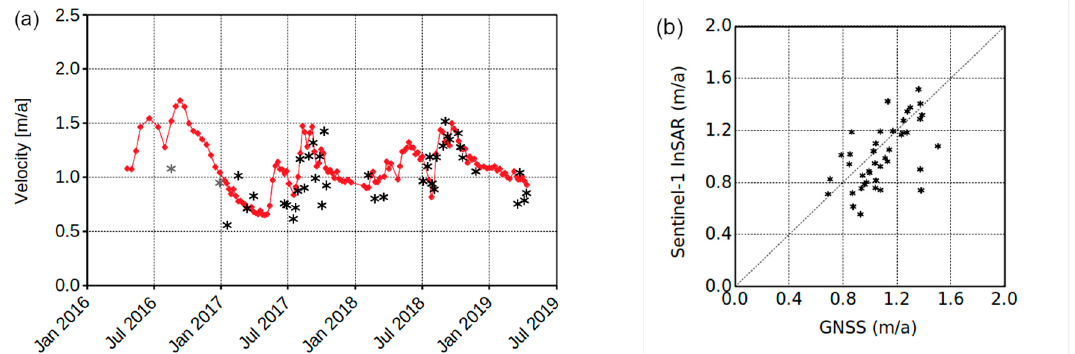
Figure 12. ( a ) Three-dimensioanl (3D) GNSS velocities computed with the average daily positions corresponding to the acquisition dates of the Sentinel-1 acquisitions (red diamonds) and velocity along the maximum slope direction from Sentinel-1 InSAR (grey 12 day time interval, black 6 day time interval) at GNSS station BdB2 over Becs-de-Besson rock glacier (Val de Réchy, Switzerland, for position see Figure 6); ( b ) Scatter plot of GNSS and Sentinel-1 InSAR velocities.